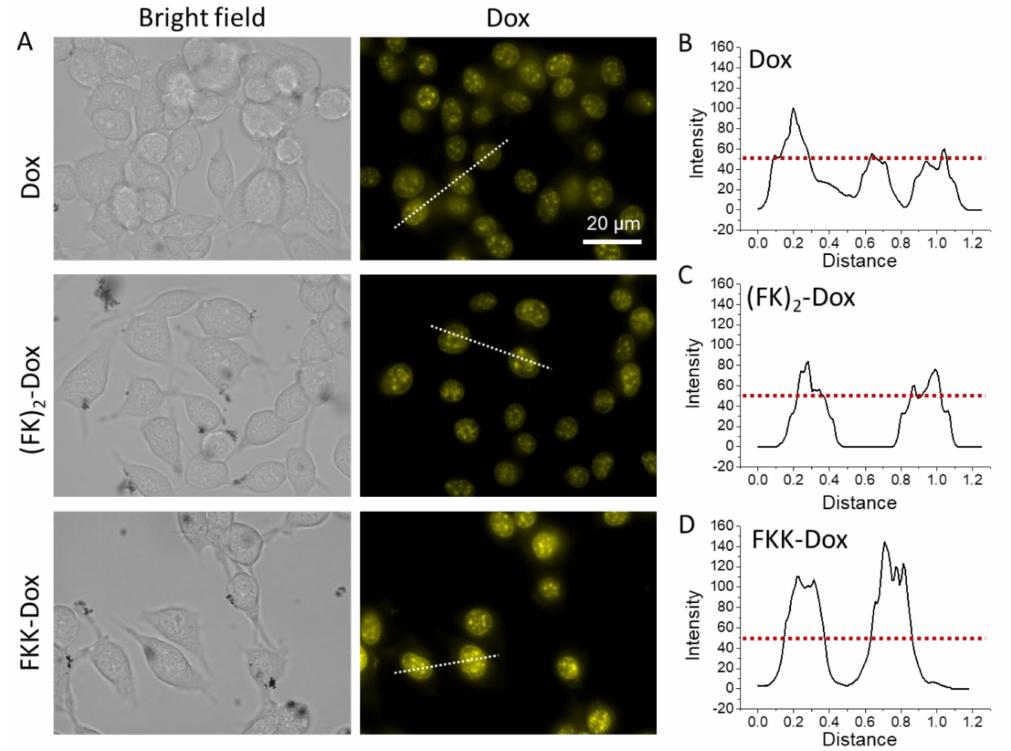
Figure 6. ( A ) Hela cell uptake of Dox (5 µ M), (FK) 2 -Dox (5 µ M of Dox) and FKK-Dox (5 µ M of Dox) analyzed by fluorescence microscopy. The images were acquired with live cells. The cells were incubated with di ff erent Dox species for 6 h, after that, the medium was removed and replaced with fresh medium. The emission of Dox was designated with yellow color. ( B – D ) The fluorescent intensity alongside the white dashed lines in Figure